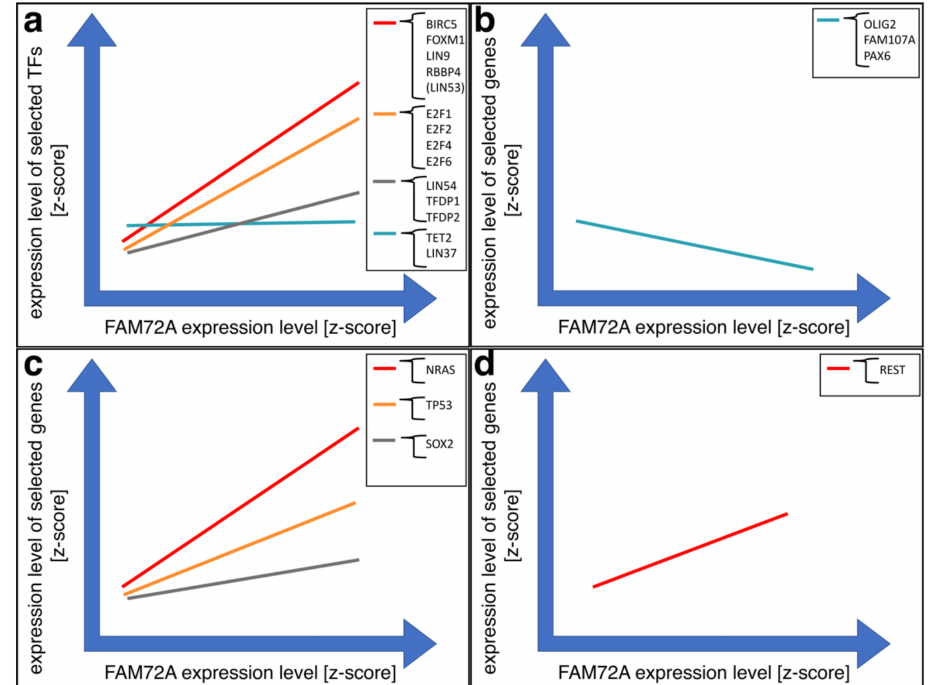
Figure 4. Schematic illustration of mRNA expression correlation of FAM72A compared with several other GBM-relevant genes, including E2Fx TFs. ( a ) FAM72A expression correlates with the expression of selected genes and TFs